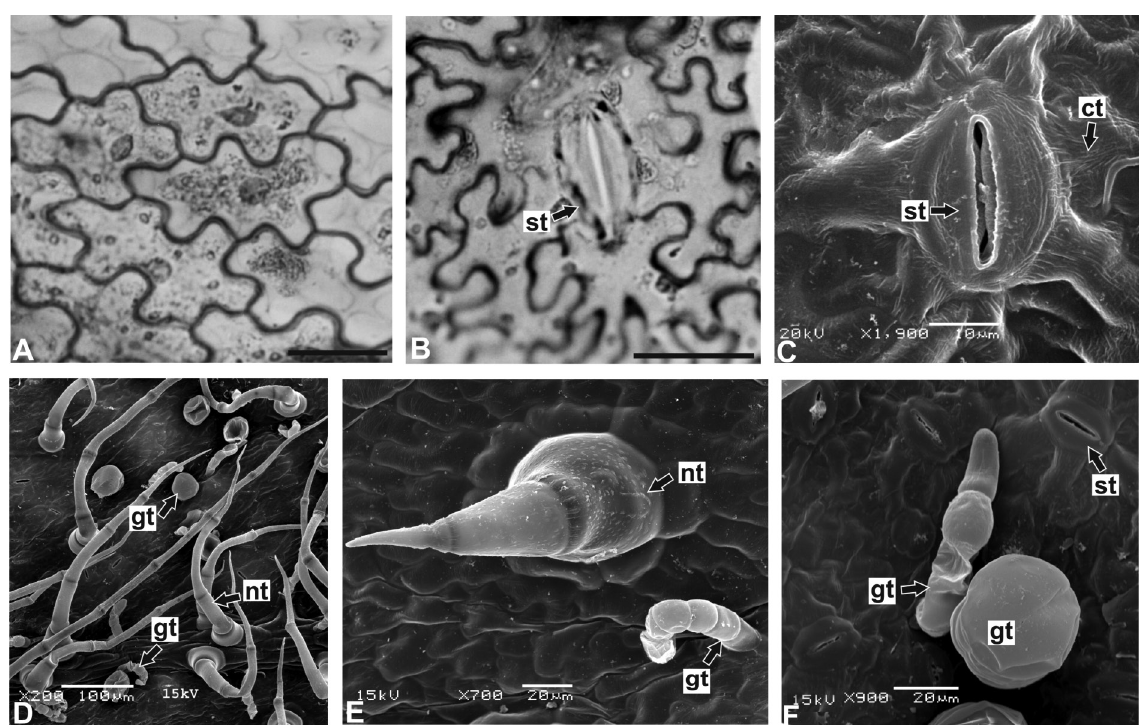
FIGURE 2 - A-F : Tithonia diversifolia (Hemsl.) A. Gray – leaf blade in surface view: A . Adaxial side; B . Abaxial surface, showing a stomatum; C . Detail of a stomatum and the slightly striated cuticle; D - F . Glandular and non-glandular trichomes. Abbreviations: ct – cuticle, gt – glandular trichome, nt – non-glandular trichome, st – stomatum. Bar = 20 m m